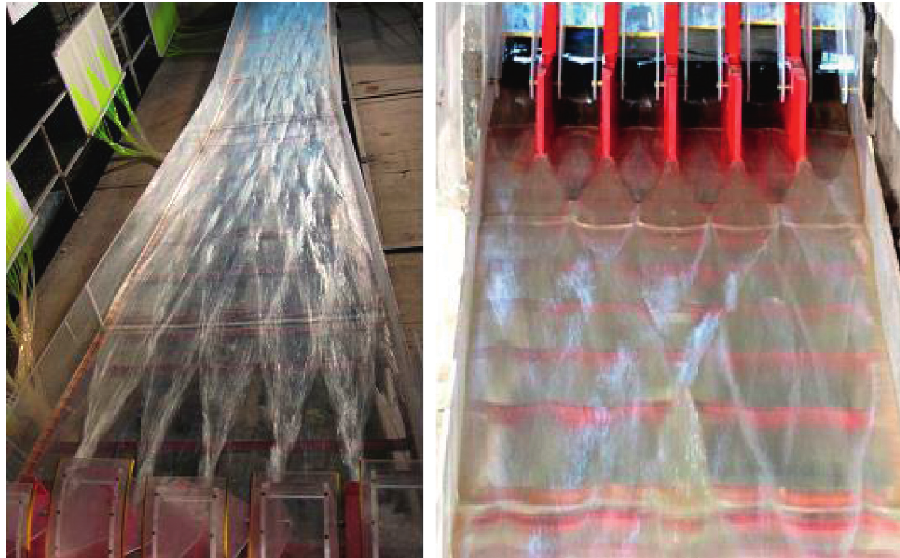
Figure 4: Geometric shapes formed from shockwaves over the chute.